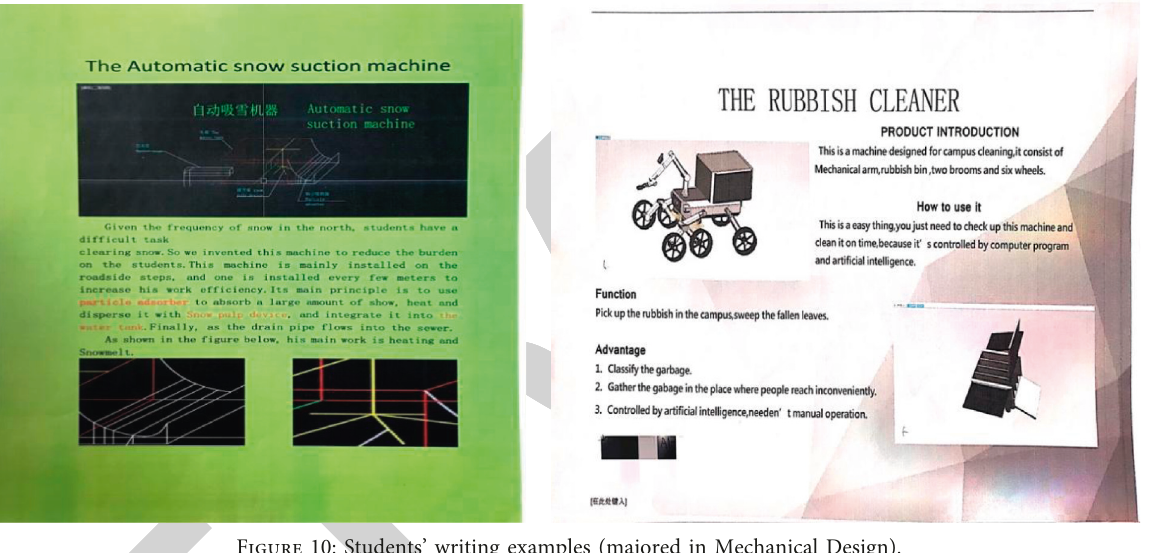
Figure 10: Students’ writing examples (majored in Mechanical